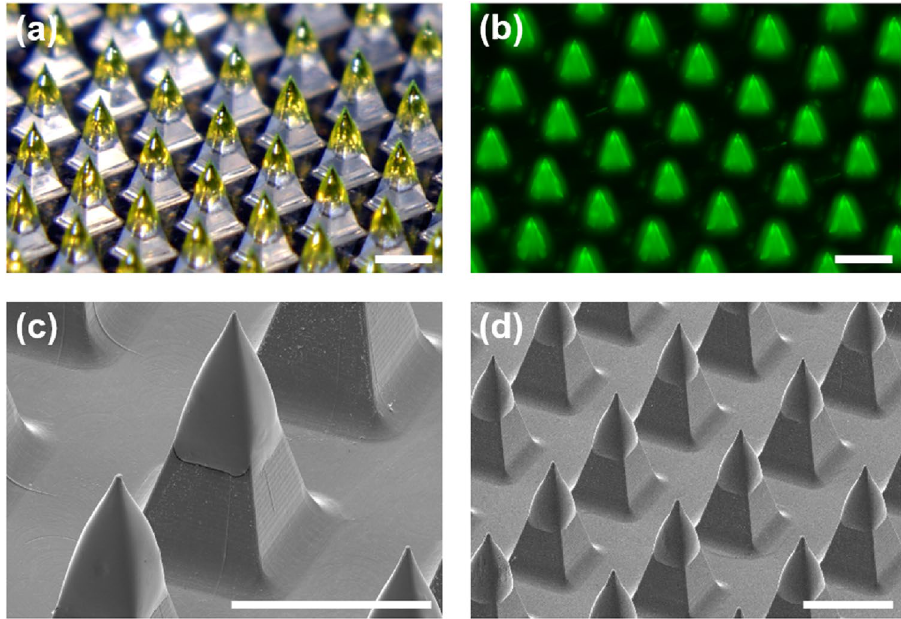
Figure 2. Images of coated microneedles. ( a ) Optical microscopic image (scale bar = 500 μm) and ( b ) fluorescence image of FITC-dextran coating layer on microneedles (scale bar = 500 μm). ( c ) Enlarged SEM image of H3N2 microneedle vaccine. ( d ) SEM image of H3N2 microneedle vaccine array (scale bar = 500 μm).